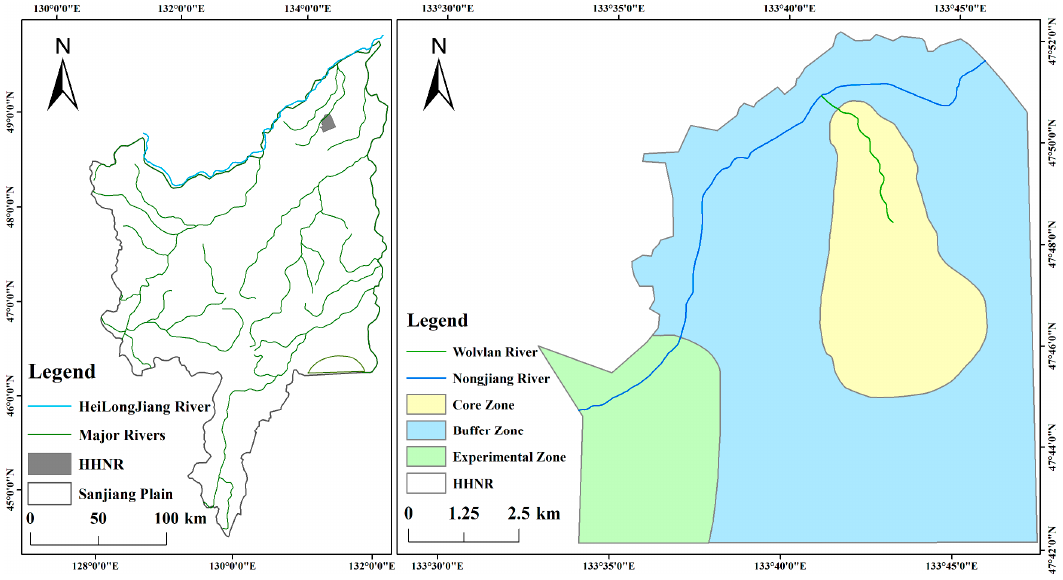
Figure 1. Location of the study area.